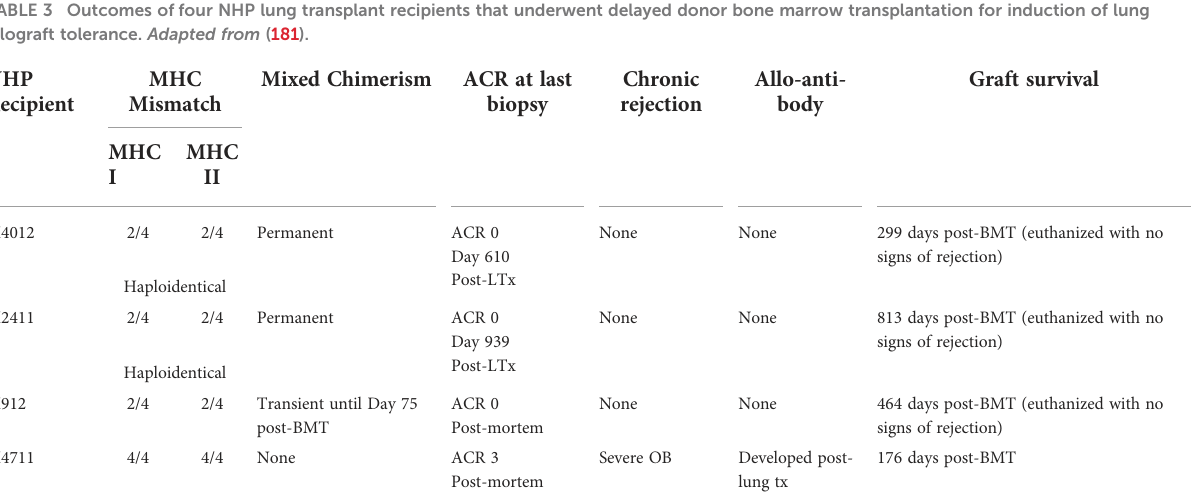
TABLE 3 Outcomes of four NHP lung transplant recipients that underwent delayed donor bone marrow transplantation for induction of lung allograft tolerance. Adapted from (181).